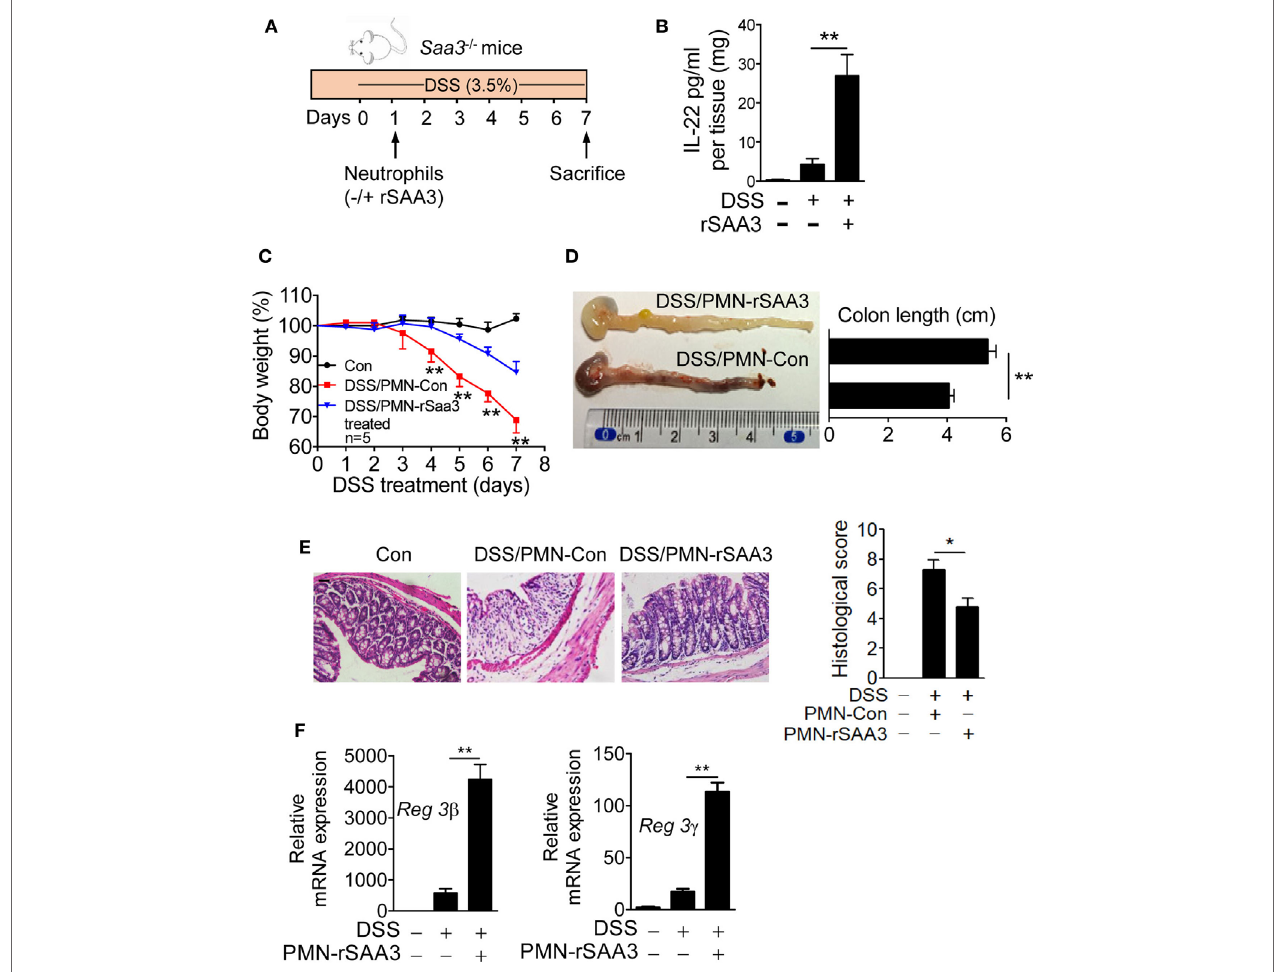
FigUre 8 | Adoptive transfer of serum amyloid A (SAA)3-treated neutrophils ameliorates dextran sulfate sodium (DSS)-induced colitis. (a) Bone marrow neutrophils from wild-type (WT) mice were incubated for 6 h with or without 1 µM of recombinant SAA3 (rSAA3) and 5 × 10 5 cells were intravenously injected into a Saa3 − / − mouse 1 day after DSS administration. (B) IL-22 released into the culture medium was measured by ELISA. (c) Body weight loss was monitored every day in Saa3 − / − mice receiving rSAA3-treated neutrophils (blue) or vehicle-treated neutrophils (red). Untreated controls were included. (D) The lengths of colons were measured with a representative image shown on the left ( n = 5 each condition). (e) Representative images of hematoxylin and eosin stained paraffin sections of distal colon tissue (left panels) and pathology scores (right; n = 5). Scale bars, 20 µm. (F) Relative mRNA levels of the antimicrobial peptides Reg3 β (left) and Reg3 γ (right) in colon tissue samples. Male and female mice 8–10 weeks of age were used in these experiments. All data were collected with triplicate measurements and shown as mean ± standard margin of error. * p < 0.05 and ** p <